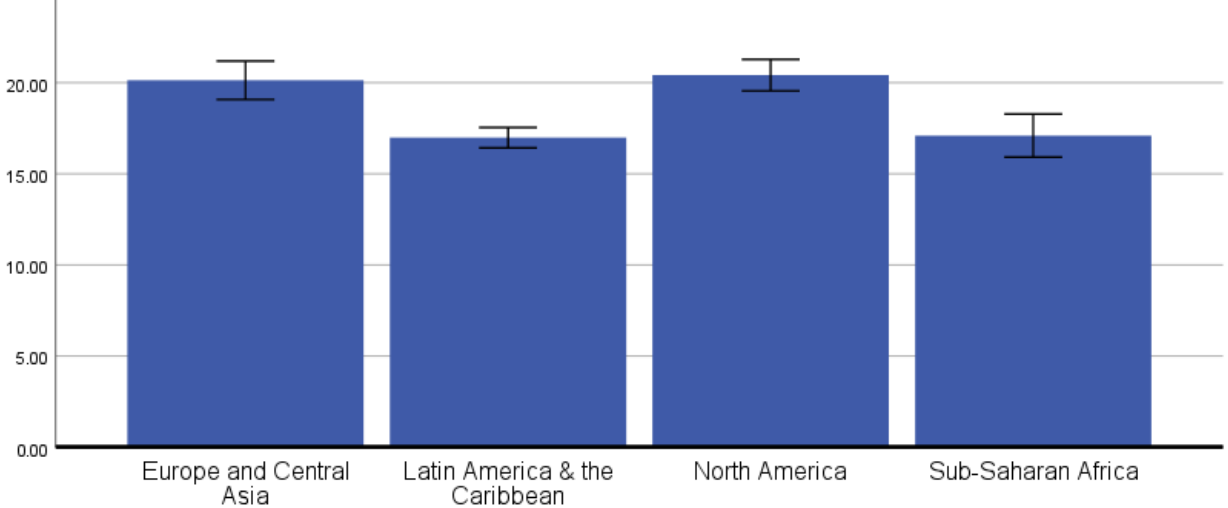
Figure 1. Covariate-adjusted somatic symptom severity scores (mean with 95% confidence interval) by global region. Note : A graphic that shows the differences in somatic symptoms by Global Region. The participants from Europe and Central Asia and North America reported significantly greater somatic symptom severity than participants from Latin America and the Caribbean and Sub-Saharan